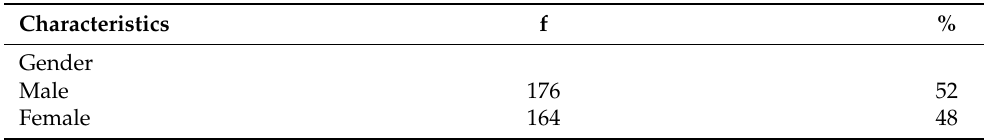
Table 1. Distribution of the sample